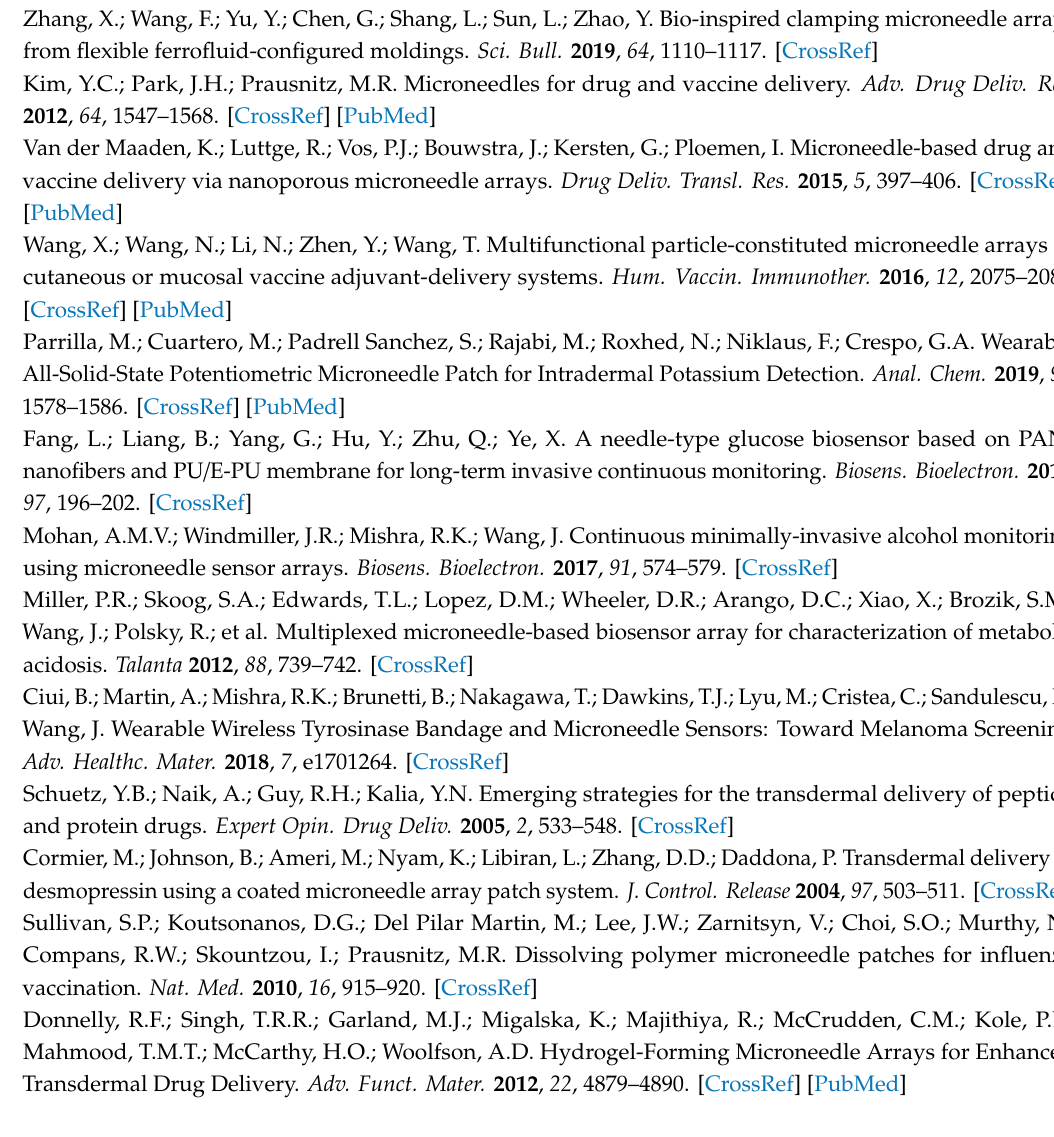
Figure S1. The impact of hydration on the mechanical properties and scale of microneedles (MNs): (a) The mechanical properties of MNs with di ff erent water content; (b) The bottom width of needle with di ff erent water content, Figure S2. The integrated density corresponding to di ff erent concentration of rhodamine B, Video S1: Mechanical performance